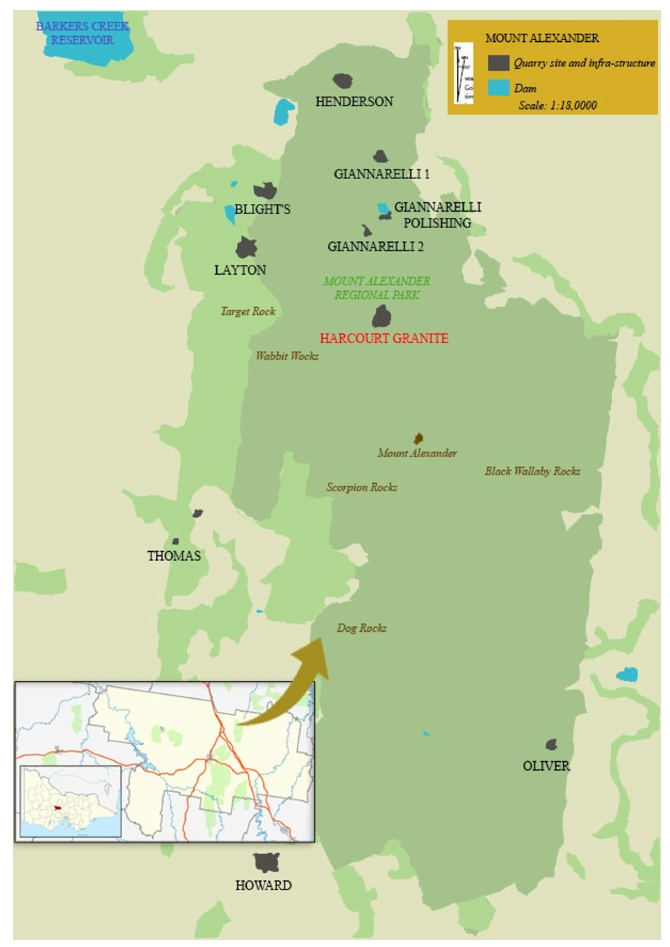
Figure 2. Location of Harcourt granite quarry near Mount Alexander [32]. Table 1. Mineralogical composition of Harcourt